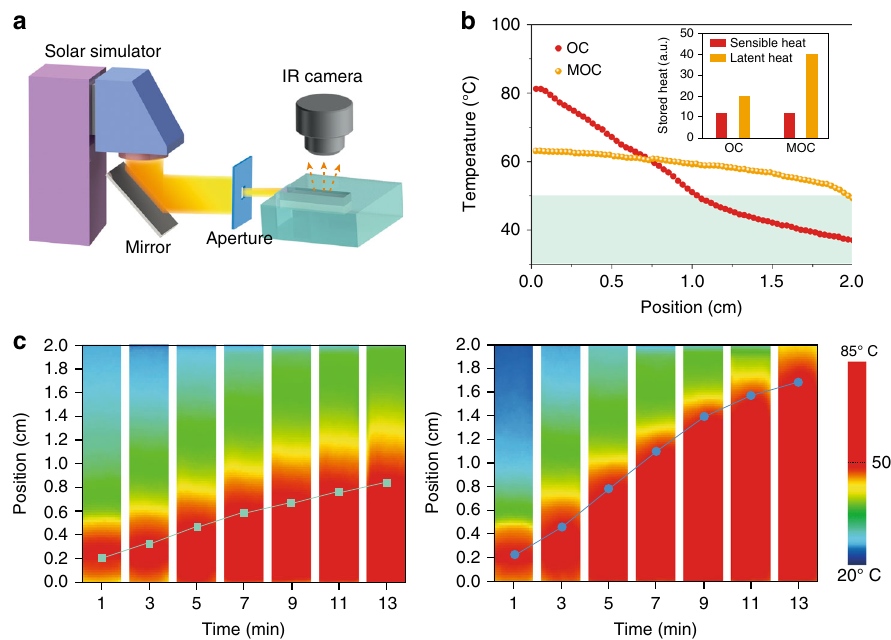
Fig. 5 Solar-thermal energy harvesting via dynamic tuning-based optical charging of paraf fi n composites. a Schematic illustration of direct solar-thermal energy harvest. b Temperature pro fi les of charged composites (with 0.1 wt% of the hybrid Fe 3 O 4 @graphene nanoparticles) under optical charging (OC) and magnetically enhanced optical charging (MOC) mode after charging for 15 min. The inset fi gure compares the corresponding portion of sensible and latent heat storage. c Time-dependent solar charging interface movement under OC (left) and MOC (right)